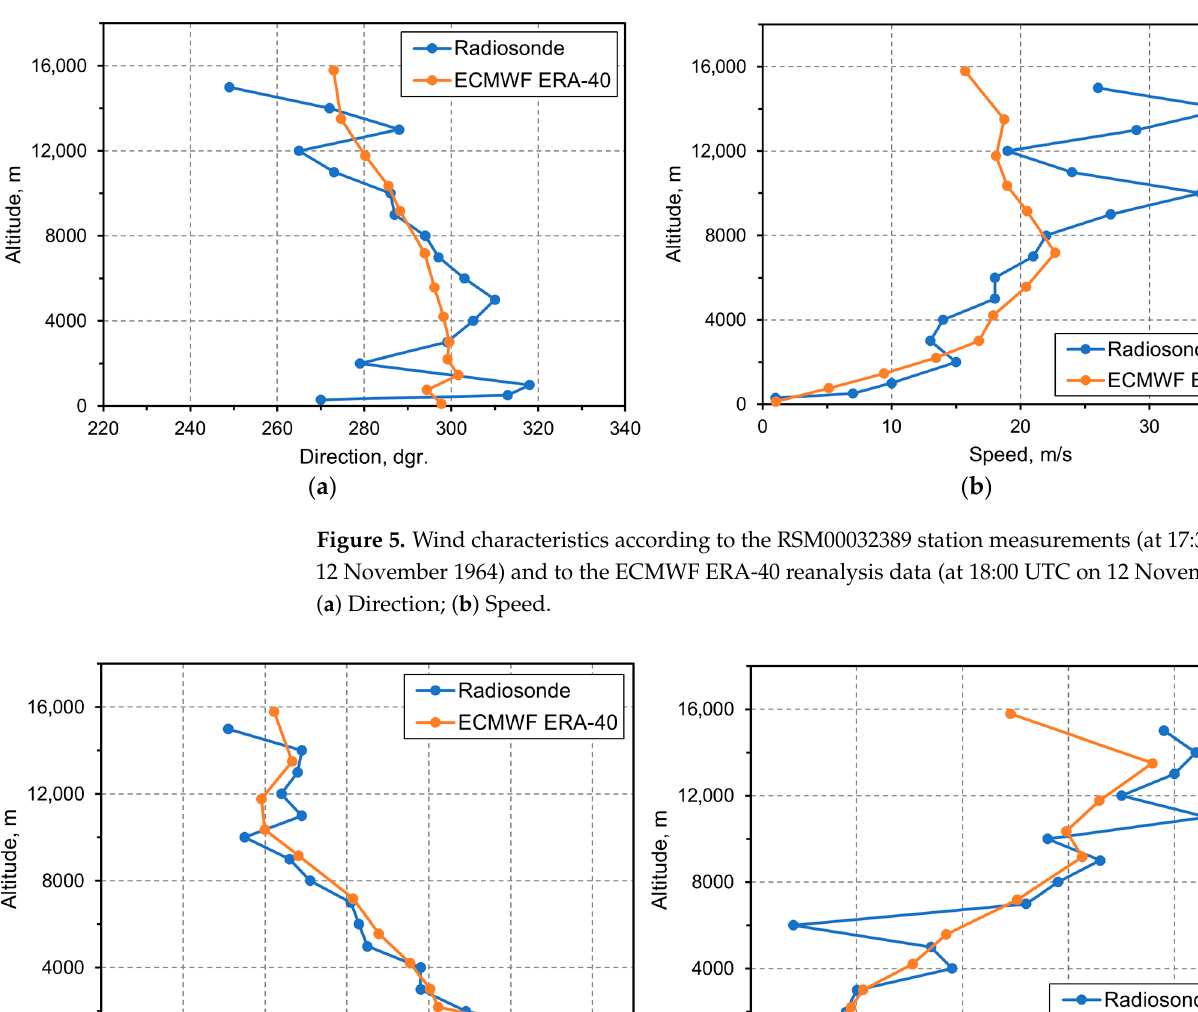
Figure 4. Cloudiness at the Sheveluch volcano during the 1964 eruption according to the ERA-40 reanalysis data: black solid line—total cloud cover; red dashed line—low cloud cover; green dot- ted line—medium cloud cover; blue dash-dotted line—high cloud cover.